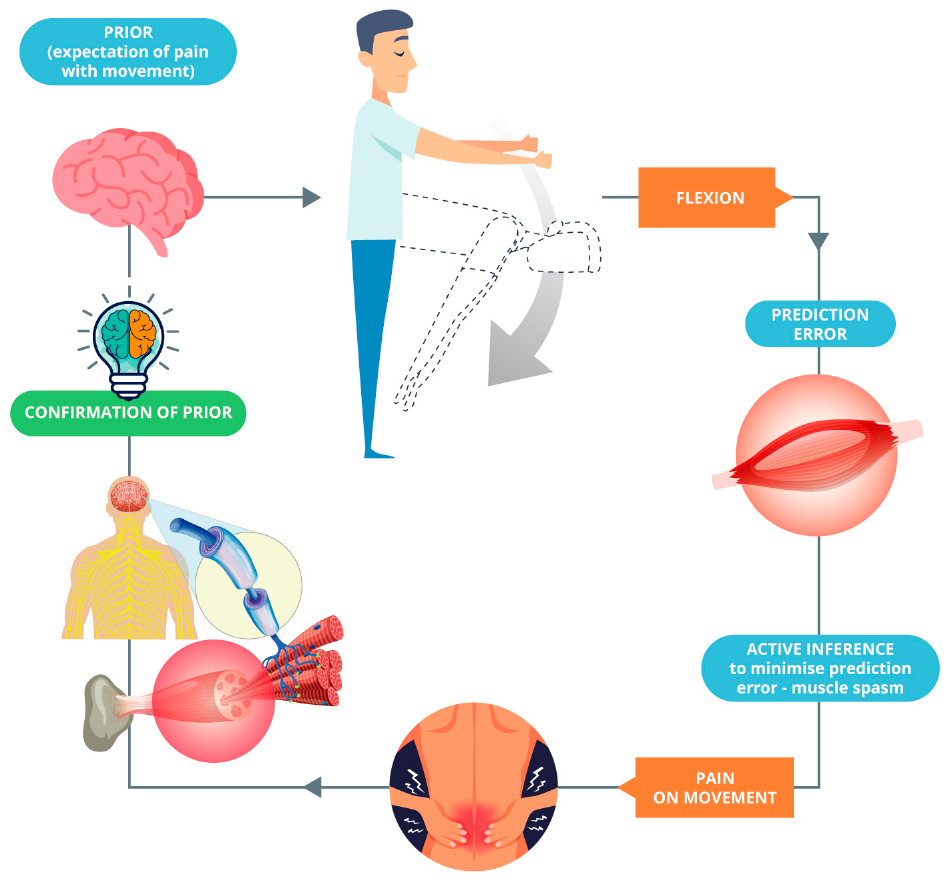
Figure 1. The expectation of pain (prior) is confirmed by the movement (confirmation of prior) through the active inference.